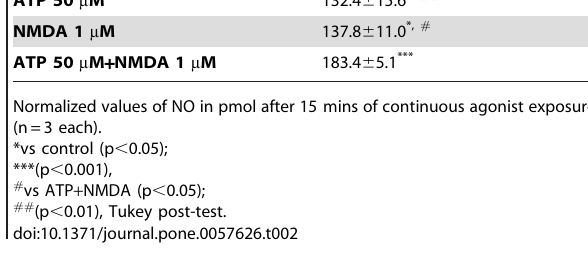
Figure S1 Representative image of glial cell contami- nation at 14 DIV. The percentage of glial contamination was obtained by counting the number of GFAP positive cells (green). Neurons are detected by b-III-tubulin immunostaining (red). (TIF) Figure S2 Western blot analysis of P2XR subtypes in hippocampus of adults rats. The fig. show the detection of P2X1, 2, 4 and 7 receptors, in three different rats. Bars indicate molecular weights in KD.